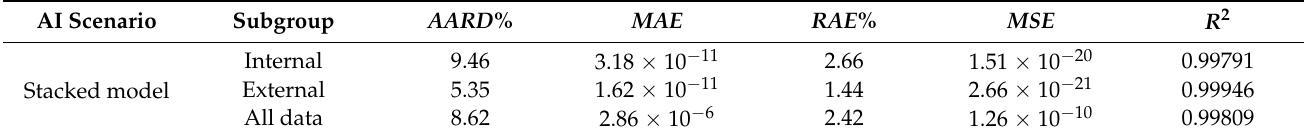
Table 4. Prediction accuracy of the stacked